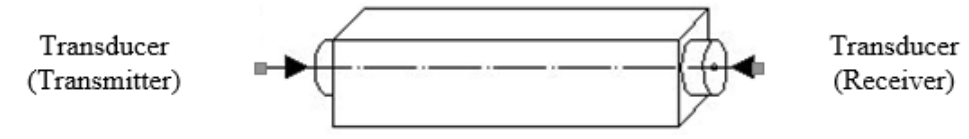
Figure 3. Scheme of direct transmission.